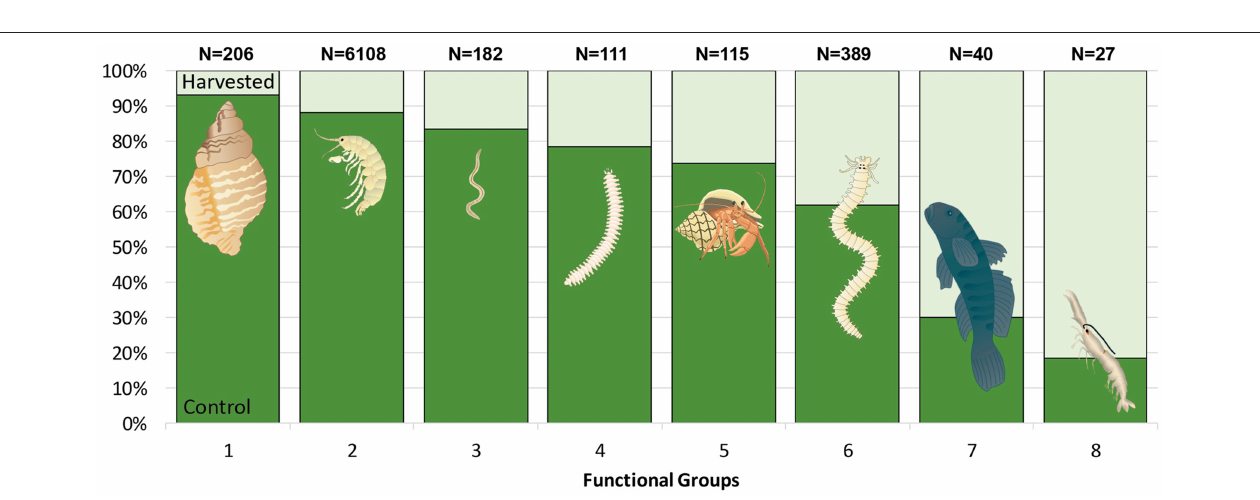
FIGURE 9 | The proportional distribution of all fauna categorized into 8 (FG) collected in control (dark green) and harvested (light green) treatments. Data are pooled from core and drop samples, collected 13 months after the start of the experiment. Bars represent the percentage of individuals within each FG that was found in each treatment. The total number of individuals per FG is given above each bar. (Images: ian.umces.edu/symbols).